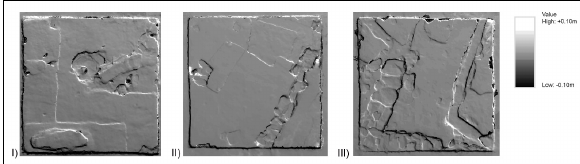
Figure 12 . Monochromatic rendering of the “difference image” resulting from the 3D model comparison (4/7/2019) between laser scanner and terrestrial DSLR Canon EOS 1200D of the: (I) first, (II) second, (III) third archaeological trench.